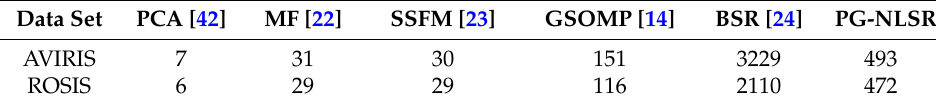
Table 4. Average Computational Time (in seconds) of Different